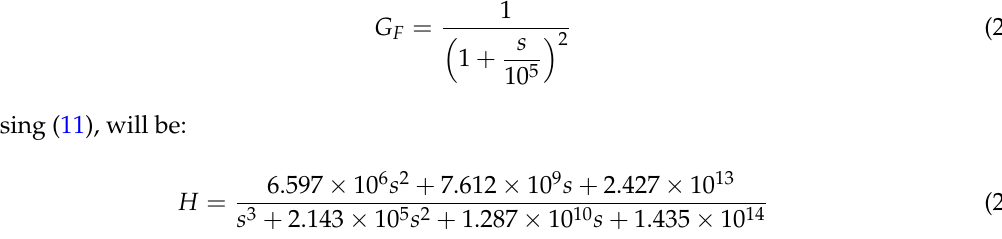
Figure 10. The impedance analysis of the prototype: ( a ) showing the interaction between Z in ; and ( b ) comparing | |